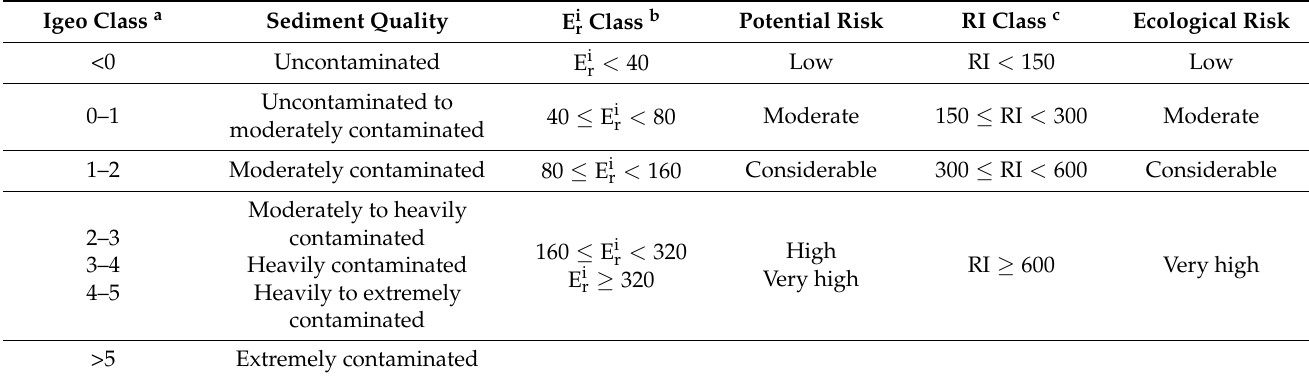
Table 2. Classes of contamination indices and corresponding